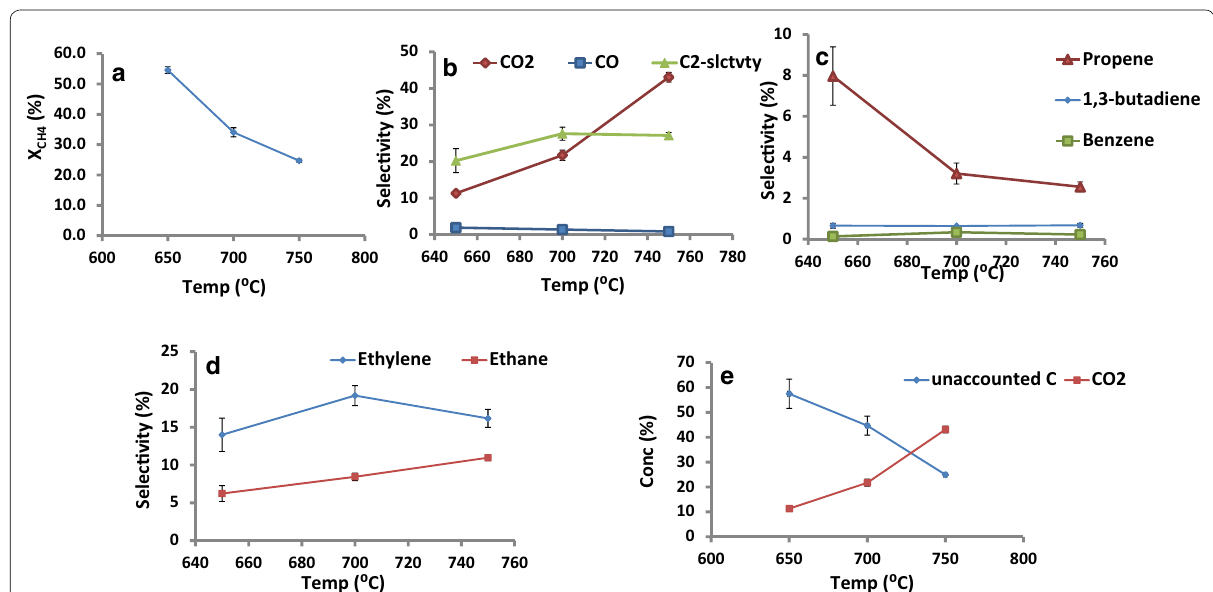
Fig. 6 Effect of temperature on ( a ) conversion of methane, ( b ) selectivity for C 2 hydrocarbons and carbon oxides, ( c ) selectivity for C 3 –C 6 hydrocarbons, ( d ) C 2 hydrocarbons, and ( e ) carbon balance and CO 2 production under the experimental conditions: 10 g of 2% Fe-loaded eggshell catalyst. 800 mL/min,